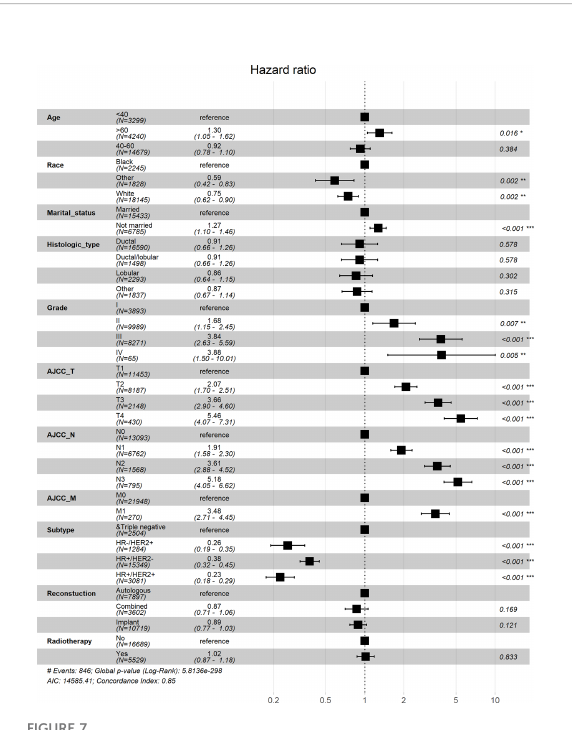
FIGURE 6 Forest map visualizing Cox multivariate regression of overall